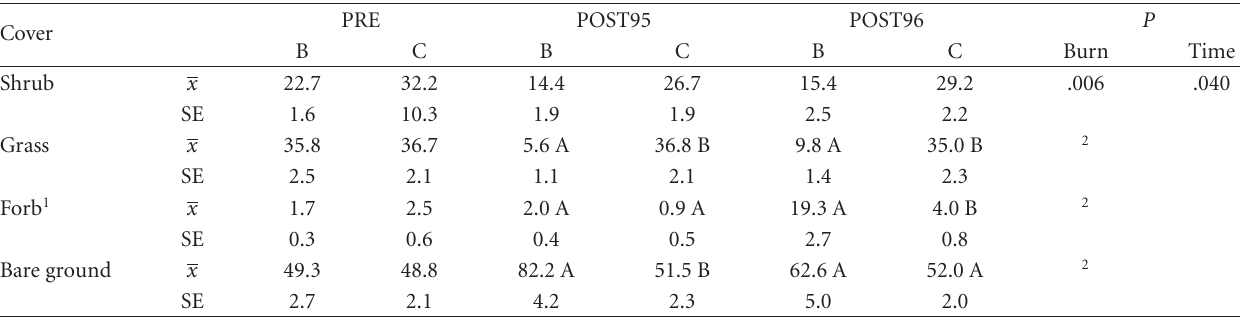
Table 1: Mean total shrub, grass, and forb canopy cover (%) and bare ground (%) prior to burning, May 1995 (PRE), one month postburn, July 1995 (POST95), and one year postburn, July 1996 (POST96), on 10 pairs of burned (B) and control (C) sites on Fort Bliss Military Reservation, Otero County, New Mexico.